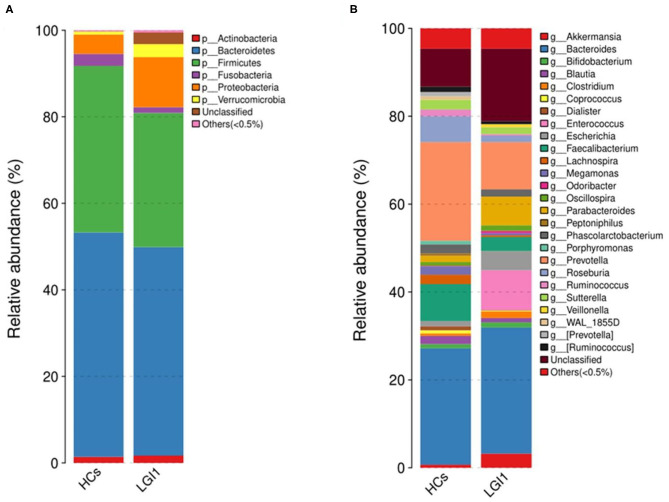
Relative abundances of microbial communities in anti-LGI1 encephalitis patients and HCs at (A) phylum level and (B) genus level.